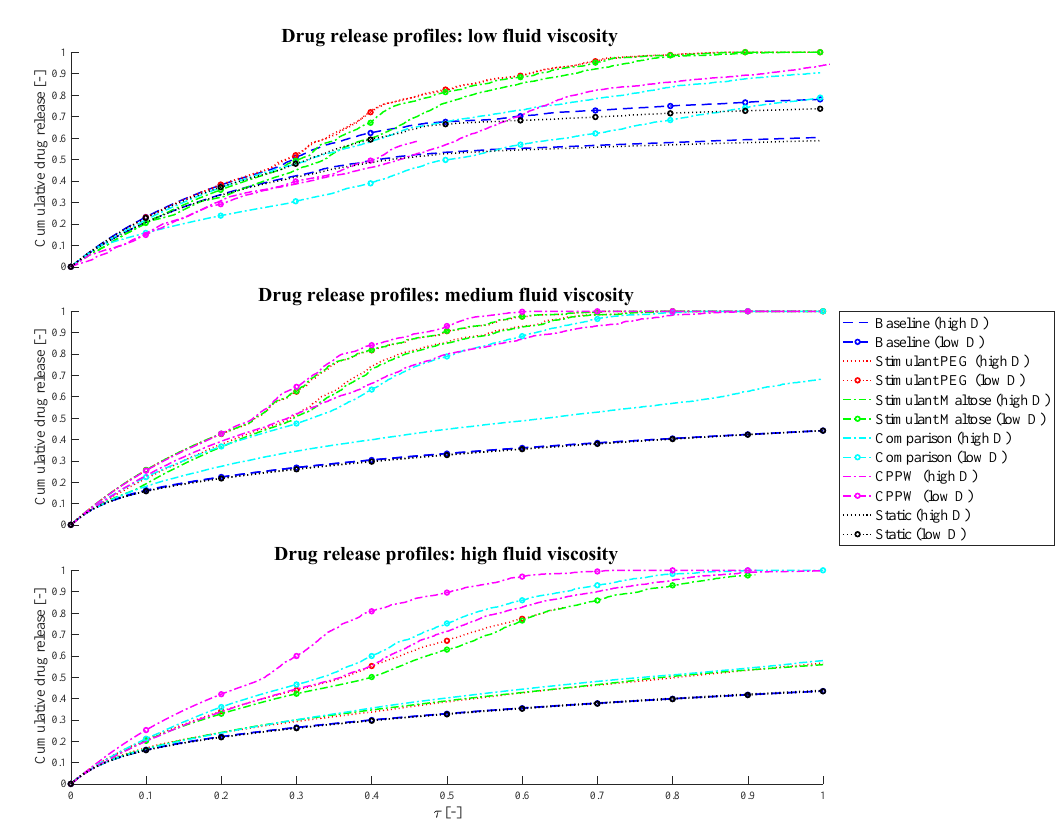
Figure 13. Comparison of the influence of different diffusion coefficients on the drug release profiles, where ‘high D’ represents the drug release profile of the high diffusion coefficient and ‘low D’ the drug release profile of the low diffusion coefficient simulation.